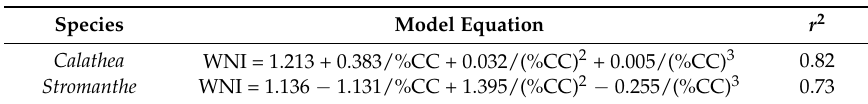
Table 2. Best fit models for predicting daily ET A values of Calathea ‘Silhouette’ and Stromanthe sanguinea during production from tissue-cultured liners to marketable sizes in 15 cm